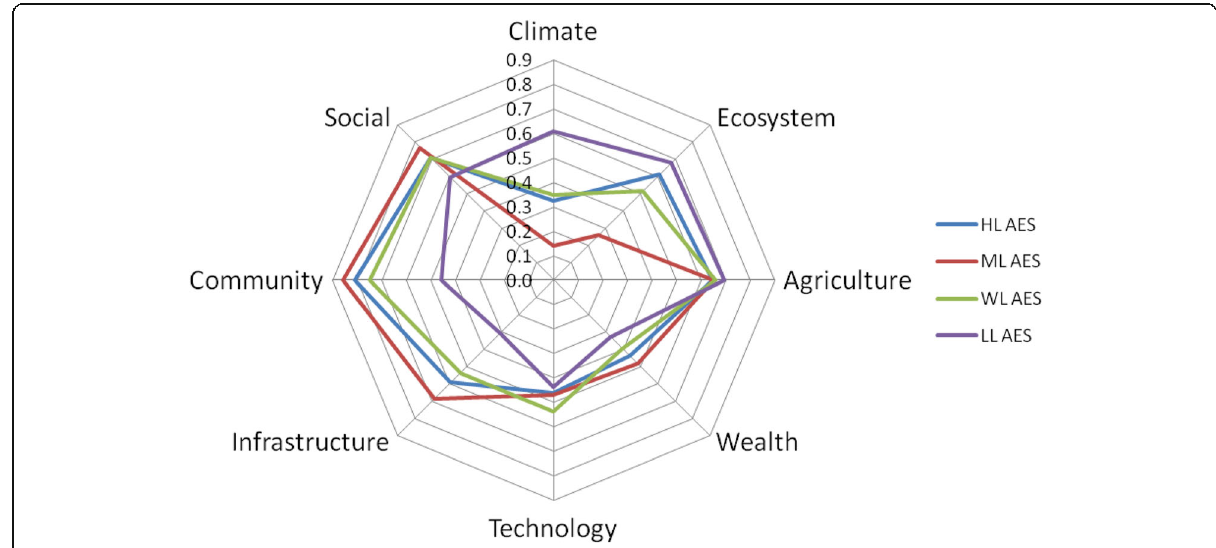
Fig. 2 Spider diagram of major profiles of Livelihood Vulnerability Index (LVI)